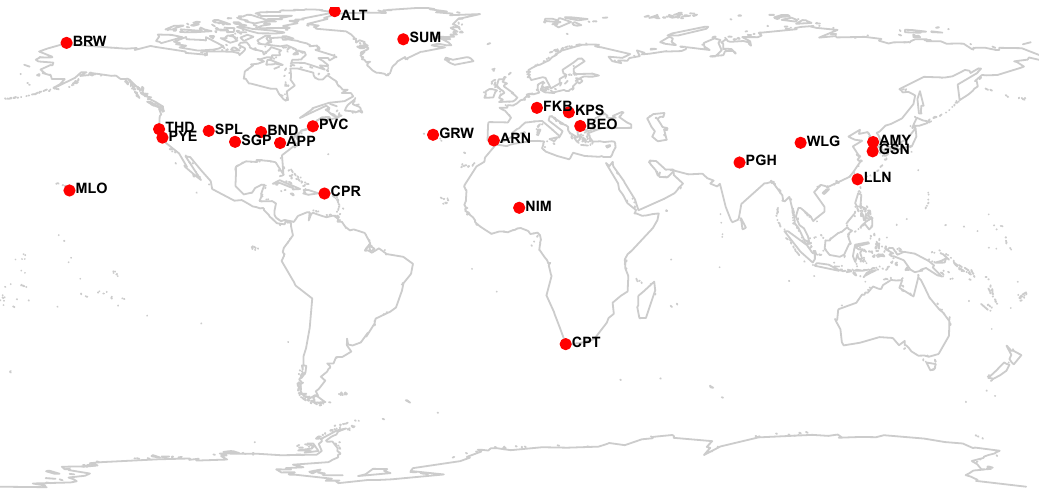
Figure 1. Map of 24 in situ monitoring stations within the NOAA/ESRL Federated Aerosol Monitoring Network that were utilized in this study. Locations are labeled with each site’s three-letter station